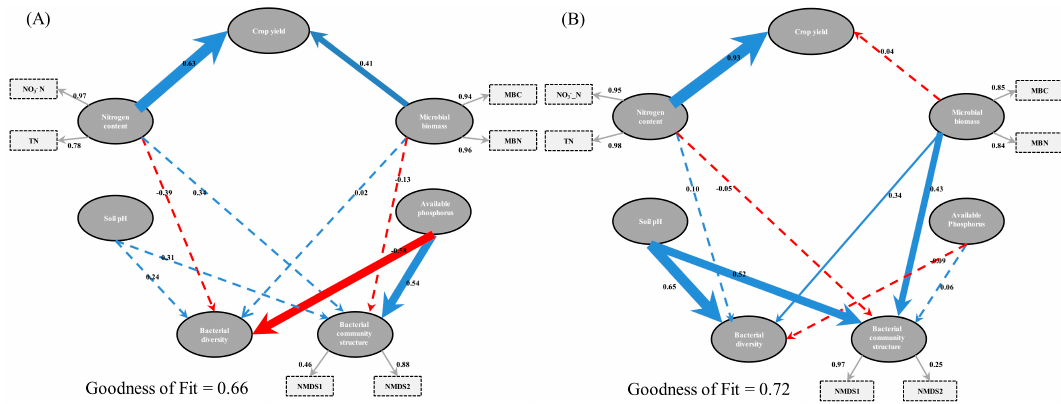
Figure 7. Directed graph of the partial least squares path model (PLS-PM). Each oval shape represents